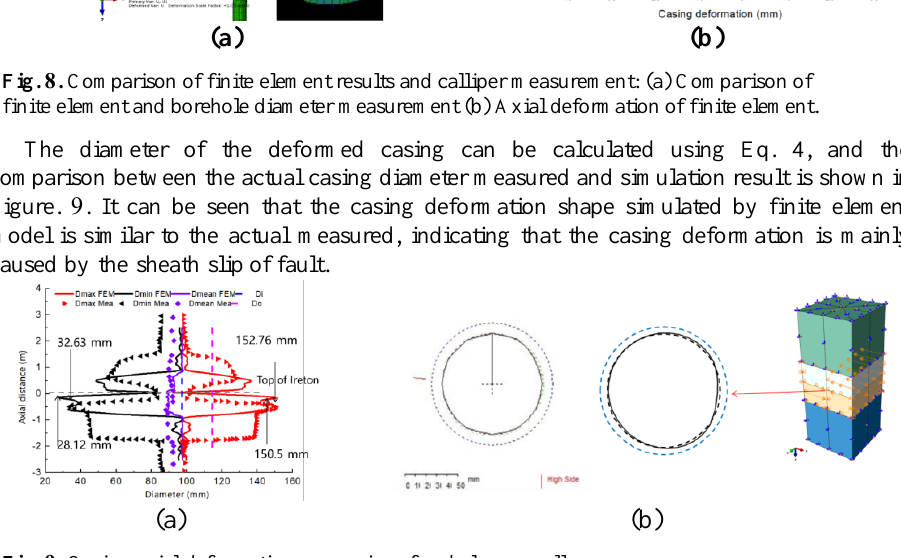
Fig. 9 . Casing axial deformation comparison for shale gas